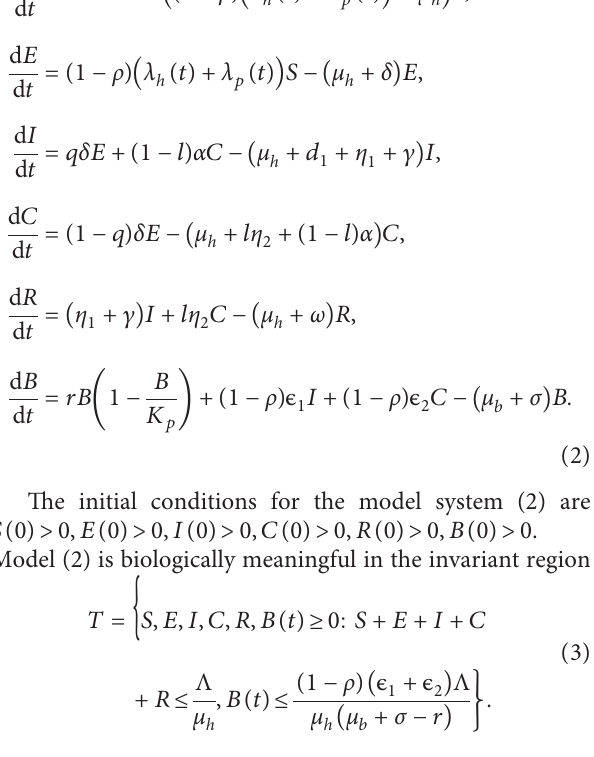
Table 1: State variables and their description. Variable Description S ( t ) The number of susceptible humans at a time t . E ( t ) The number of exposed humans at a time t . I ( t ) The number of infectious humans at a time t . R ( t ) The number of recovered (immune) humans at a time t . C ( t ) The number of carriers at a time t . B ( t ) The number of Shigella bacteria at a time t